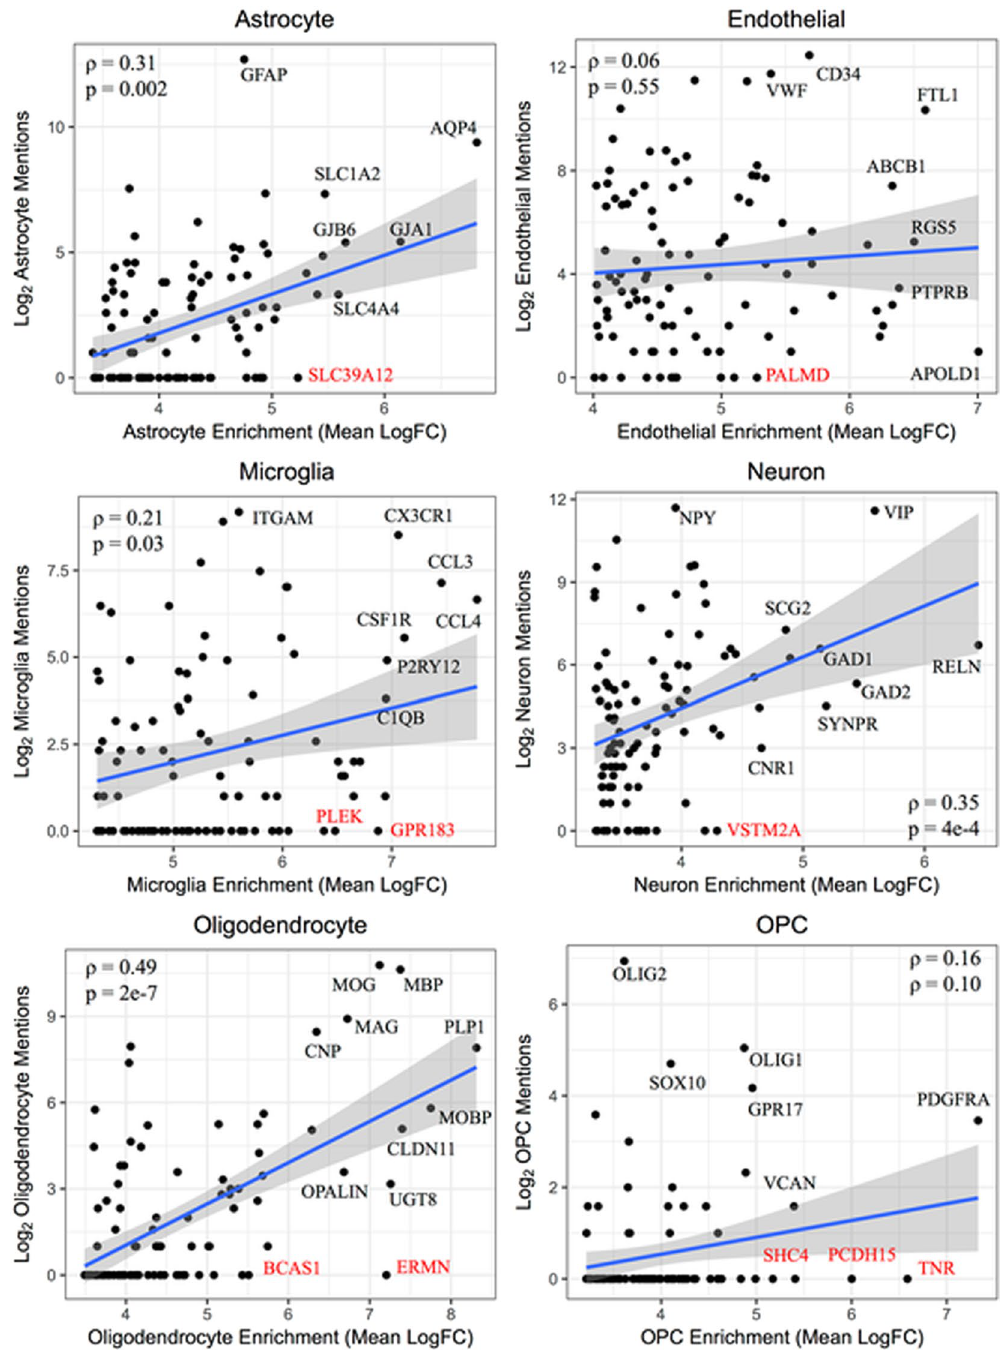
Figure 4. Correlation of genewise cell type enrichment measures with PubMed text mining results within cell types. For each of the six cell types, i.e. the astrocyte ( a ), endothelial cell ( b ), microglia ( c ), neuron ( d ), oligodendrocyte ( e ), and oligodendrocyte precursor cell ( f ), the top 100 gene symbols most enriched in that cell type are plotted against the number of PubMed abstracts that mention both that gene symbol as well as the corresponding cell type. The Spearman correlation between these measures was calculated. Several gene symbols were chosen for highlighting, including gene symbols that have not been mentioned in a PubMed abstract with that cell type to date (labeled red). Note that for oligodendrocyte precursor cells (OPCs), the cell type name used in the PubMed search was “oligodendrocyte